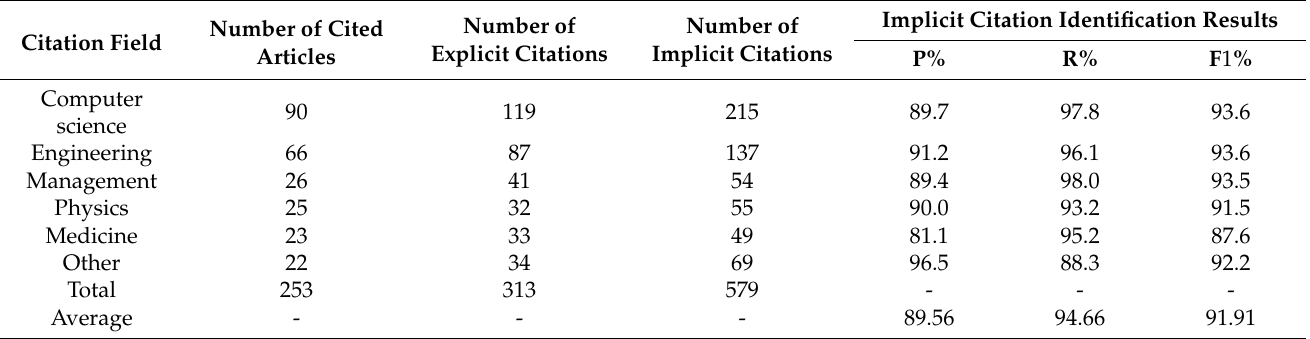
Table 7. Implicit citation sentence detection results of highly cited papers with deep neural network.